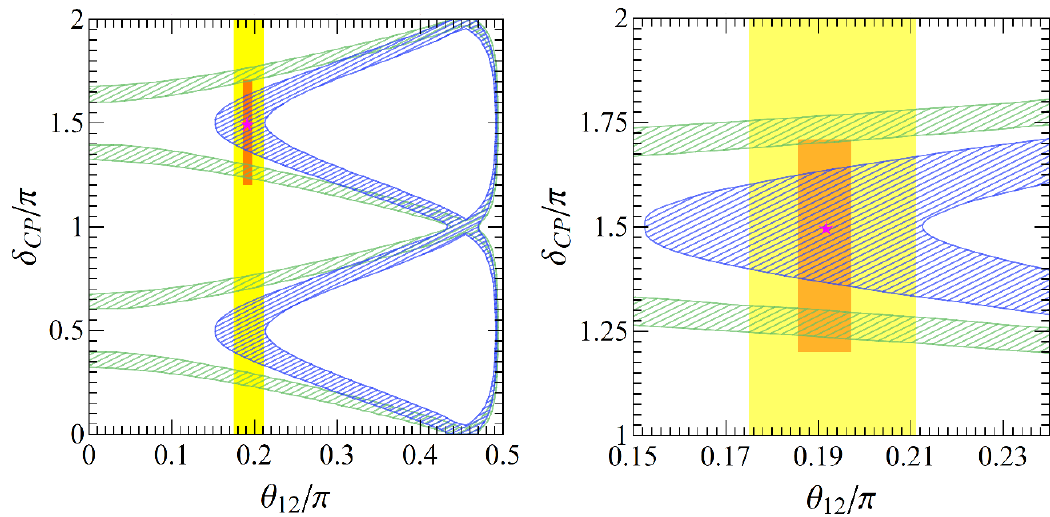
Figure 4 . Predicted correlation between the Dirac CP phase (cid:14) CP and the solar mixing angle (cid:18) 12 in the case of generalized e (cid:0) (cid:28) re(cid:13)ection, when (cid:18) 13 and (cid:18) 23 are in the 3 (cid:27) ranges given in [3]. The vertical orange and yellow bands are the currently allowed 1 (cid:27) and 3 (cid:27) (cid:18) 12 and (cid:14) CP regions respectively for normal ordering, while the star denotes the best (cid:12)t point. The green and light blue hatched regions correspond to (cid:2) = (cid:25)= 12 and (cid:2) = (cid:25)= 9 respectively.